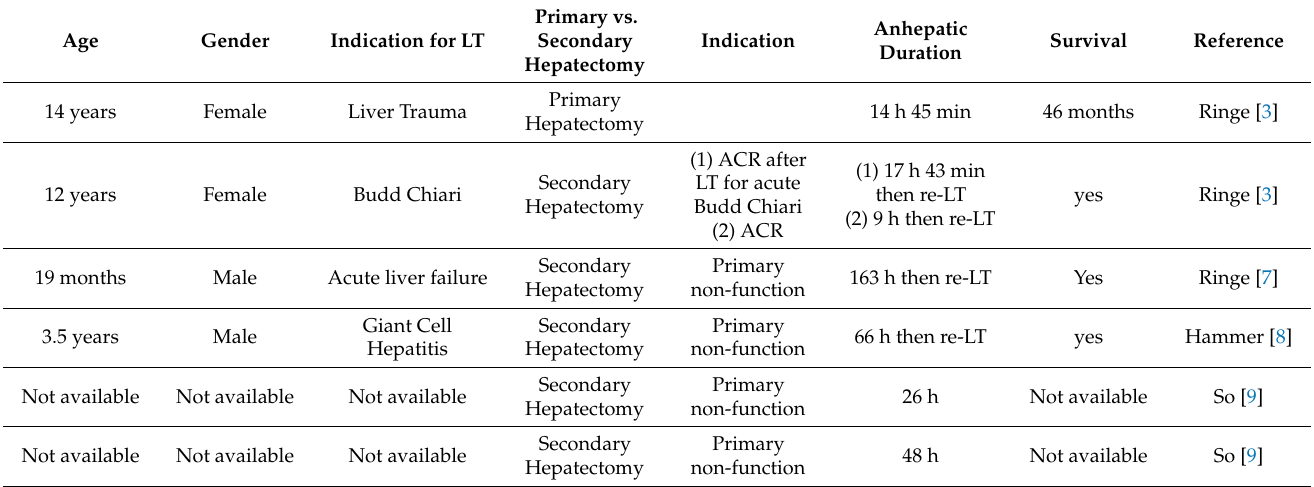
Table 1. Summary of available